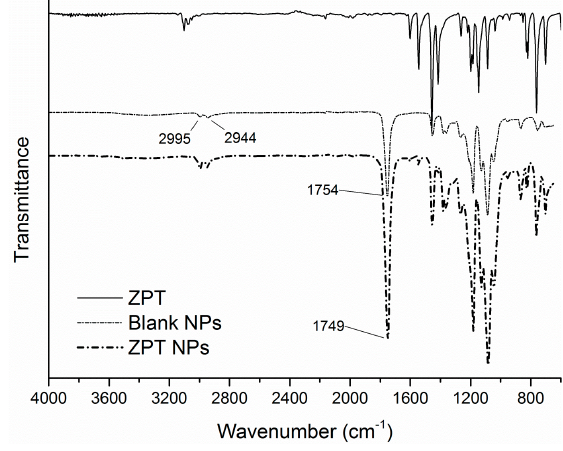
Figure 6. FTIR-ATR spectrum of ZPT NPs and comparison spectra.